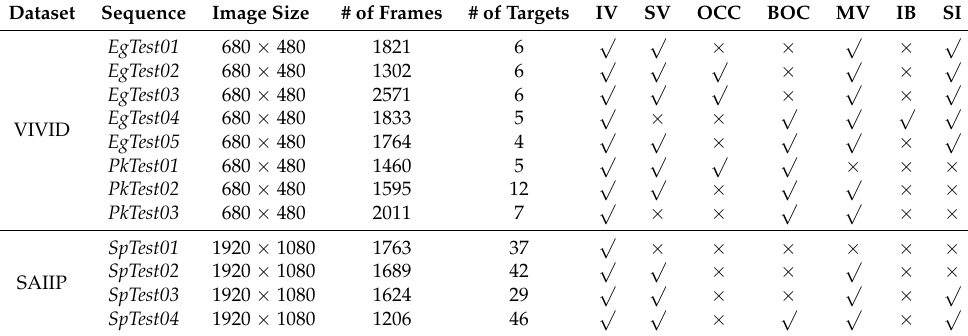
Figure 6. Scenes from the public Video Verification of Identity (VIVID) dataset (first two rows) and the Shaanxi provincial key laboratory of speech and Image Information Processing (SAIIP) dataset (last row). Table 1. Used benchmark sequences: Illumination Variation (IV), Scale Variation (SV), Occlusion (OCC), Background Occlusion (BOC), Motion Variation (MV), Image Blurring (IB), and Shadow Interference